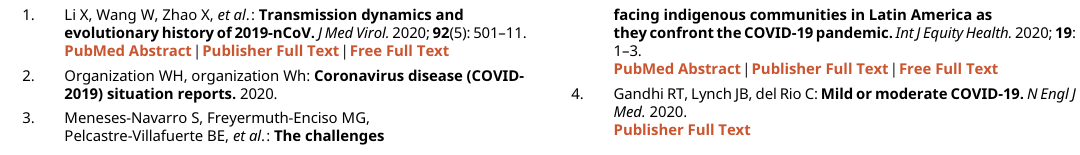
Figshare: Database including information of COVID-19 patients from Peru. DOI: https://doi.org/10.6084/m9.fig- share.14170955.v1.